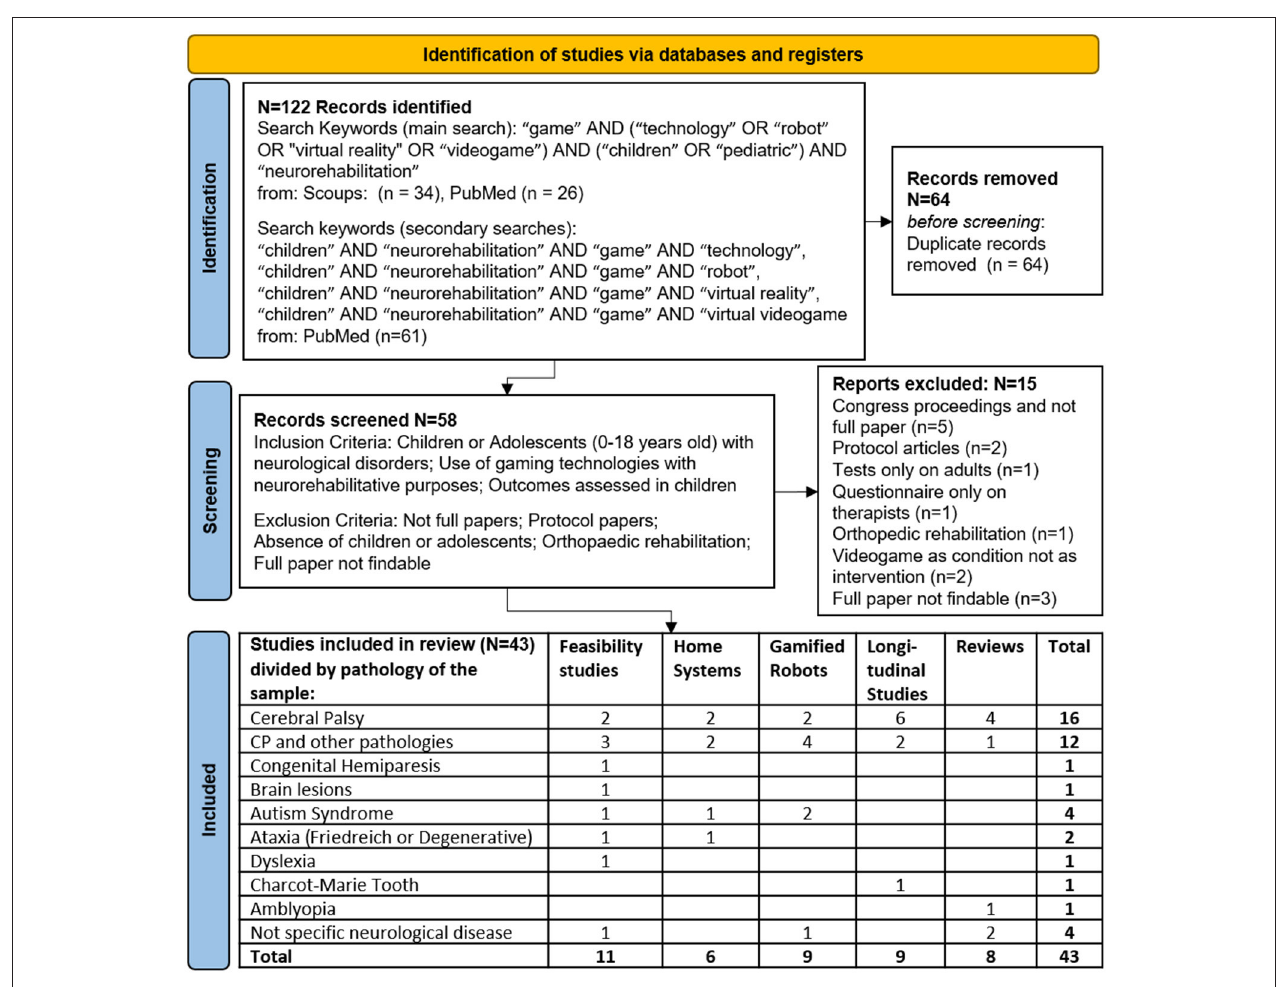
FIGURE 1 | Flow diagram of the mini review described according to the PRISMA statement